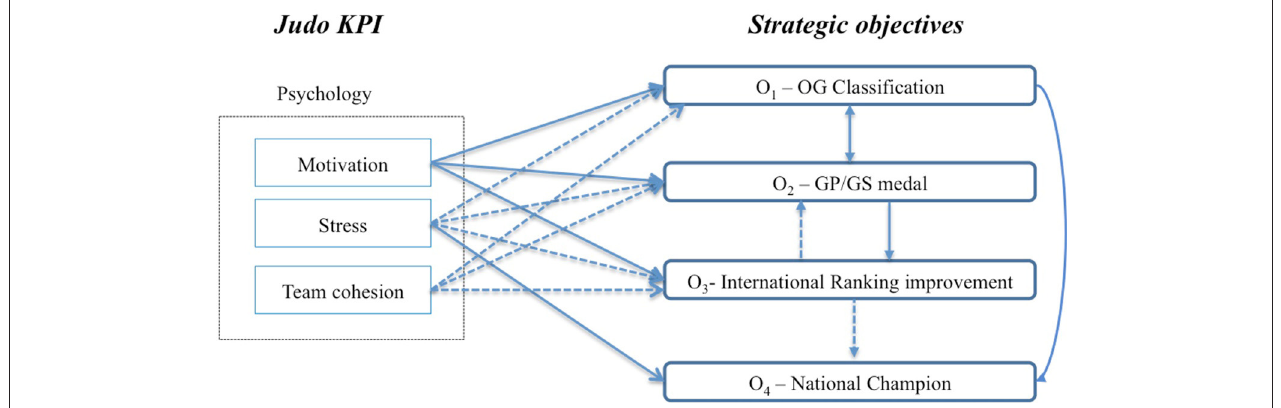
FIGURE 3 | Impact of KPI on the strategic